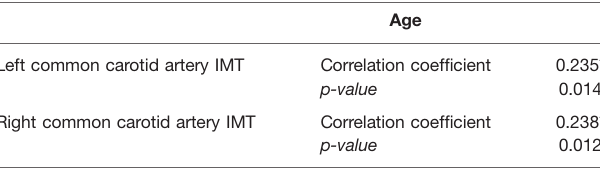
TABLE 2 | Pearson correlation analysis of age and IMT of the left common carotid artery and IMT of the right common carotid